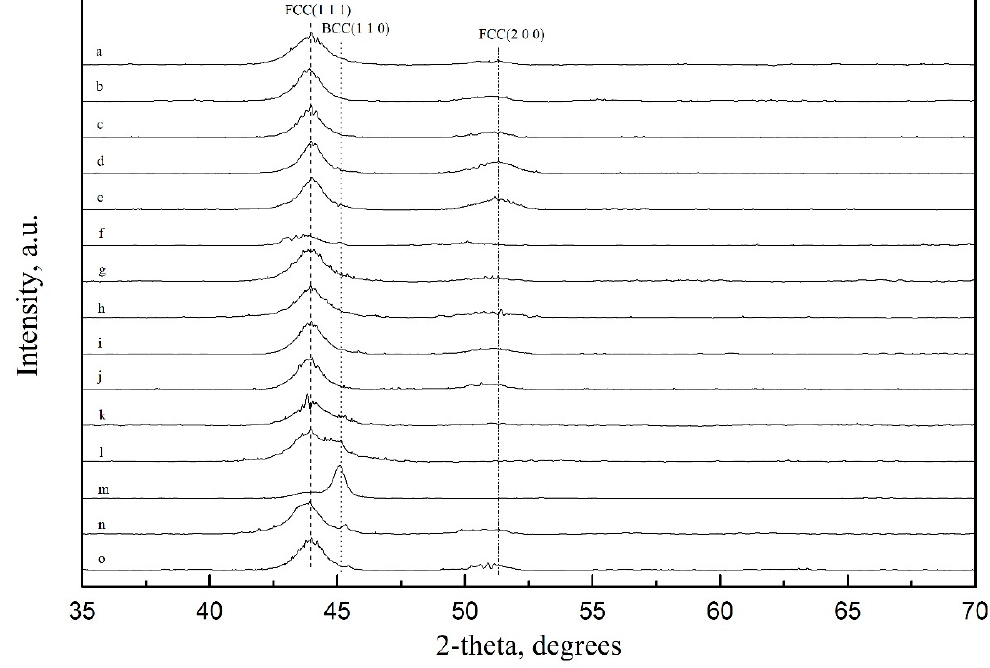
Figure 8. XRD spectra of FeNi electrodeposited thin films: (a–e) 0.015 M FeSO 4 , (f–j) 0.03 M FeSO 4 , (k–o) 0.05 M FeSO 4 . At each FeSO 4 concentration, the deposition current densities are 15 mA · cm − 2 ,